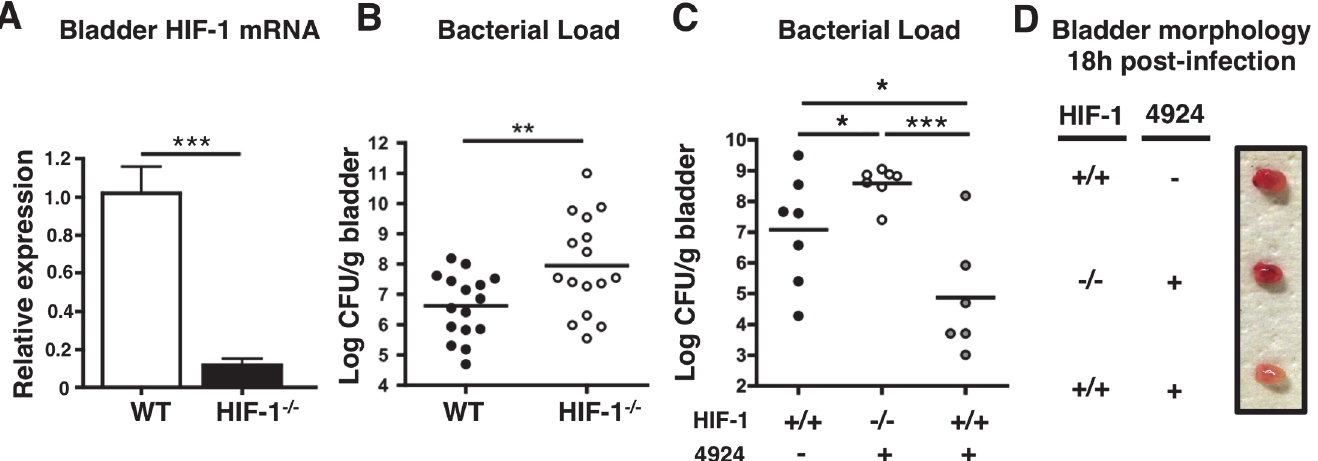
Fig 4. Mice lacking HIF-1 in their bladder epithelium are more susceptible to UPEC urinary tract colonization. ( A ) Level of Hif-1 transcripts in bladders of HIF-1 -/- ( Hif1 α flox/flox /K14-Cre + ) mice compared to wild-type mice (n = 3). ( B ) WT or HIF-1 -/- mice were infected with UPEC CFT073 and bladders were harvested 24 h post-infection for CFU enumeration (n = 16). ( C ) WT or HIF-1 -/- mice were pre-treated with 1 h of 0.2mg of AKB-4924 and infected with UPEC. Bladders were harvested 18 h post-infection for CFU enumeration (n = 7). ( D ) Images of representative UPEC infected bladders from littermates (n = 3 – 4 per group) with or without prior AKB-4924 treatment. Error bar = S.E.M *** P < 0.001, ** P < 0.01, * P < 0.05, Student ’ s two-tailed unpaired t-test. Results are mean values from 2 or more independent